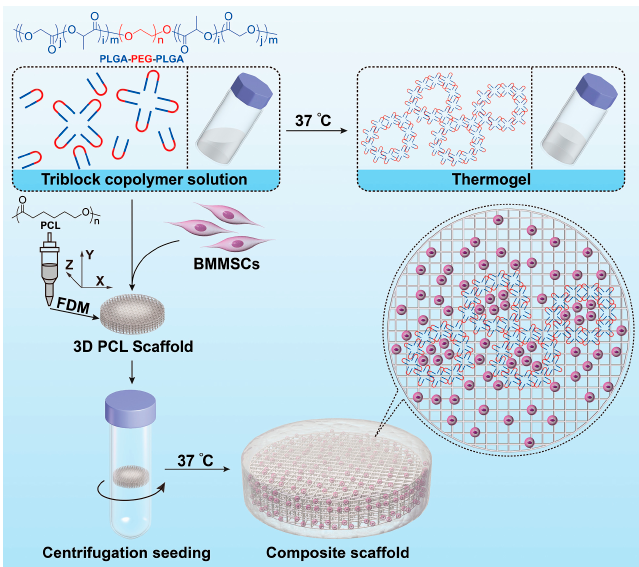
Figure 1. Schematic illustration for fabrication of PCL/Gel composite scaffold as matrix of BMMSCs.